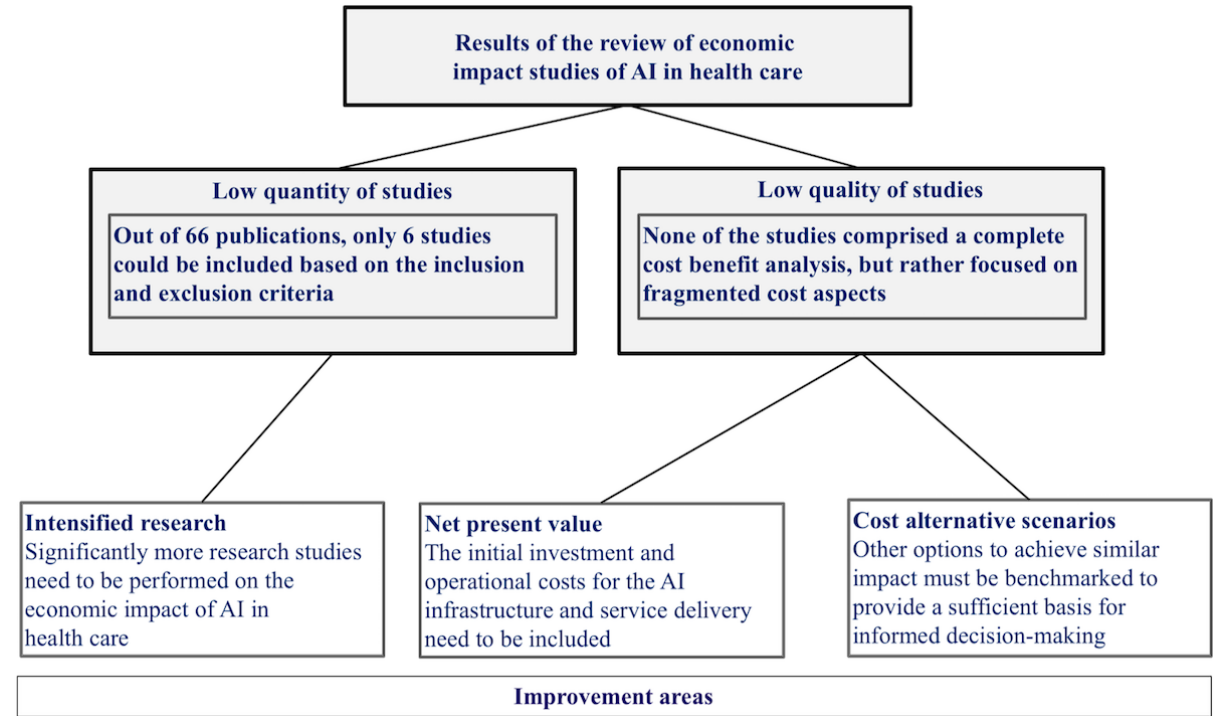
searched phrases by far in this segment ( Artificial Intelligence and Machine Learning ) in combination with the economic impact ( Cost effectiveness , Economic impact , Cost saving